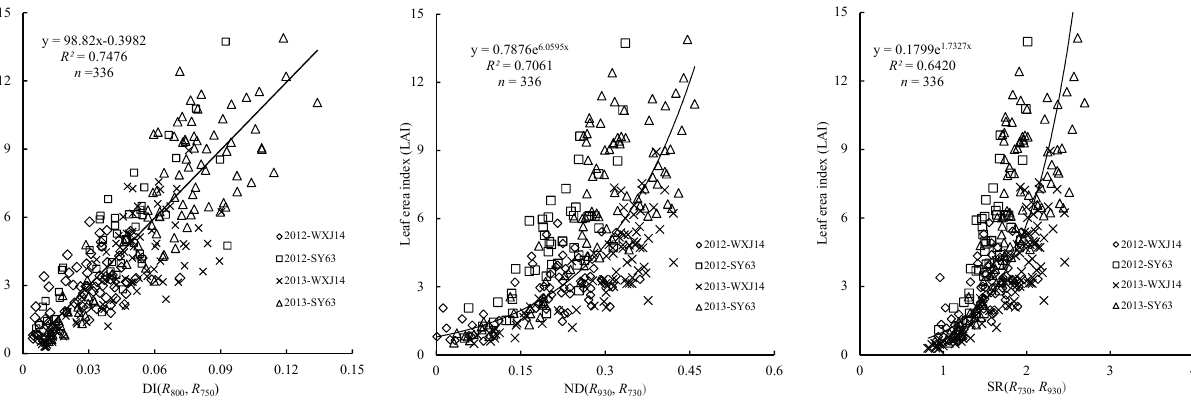
Figure 2. Relationship between the canopy leaf area index and spectral index in